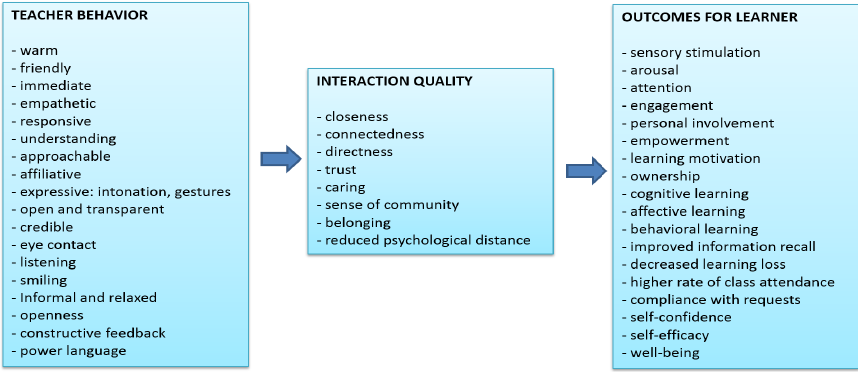
Fig. 1. Teacher immediacy and its mediating role for learner